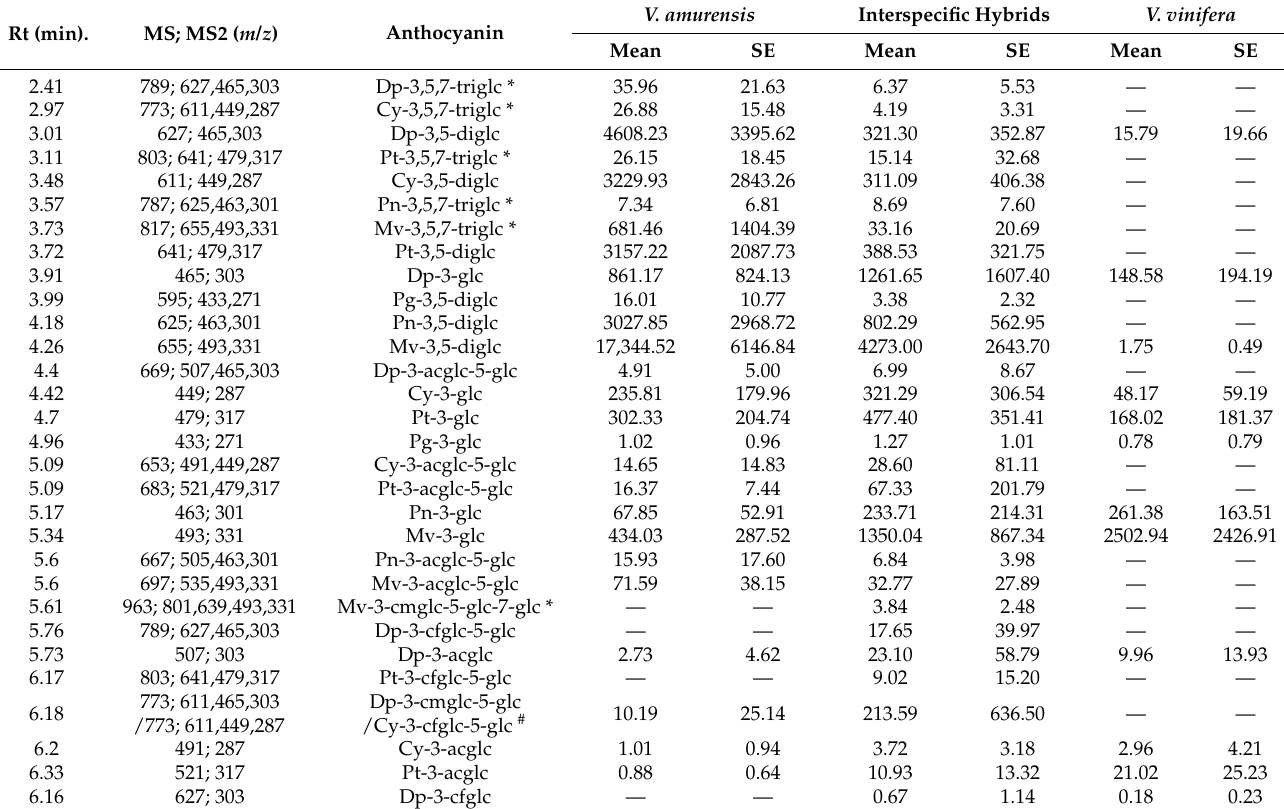
Table 2. Retention times, MS/MS 2 m / z values and mean contents ( µ g MGE/g DM) of anthocyanin compounds detected in the skins of grape cultivars/accessions belonging to the three study groups by Q-Exactive orbitrap MS. Rt